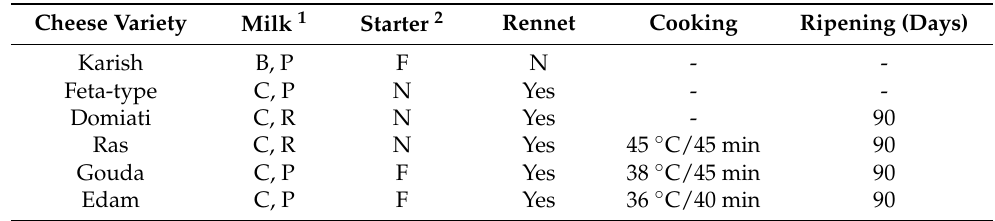
Table 1. Main manufacturing conditions and characteristics of the six different cheese varieties analysed in this